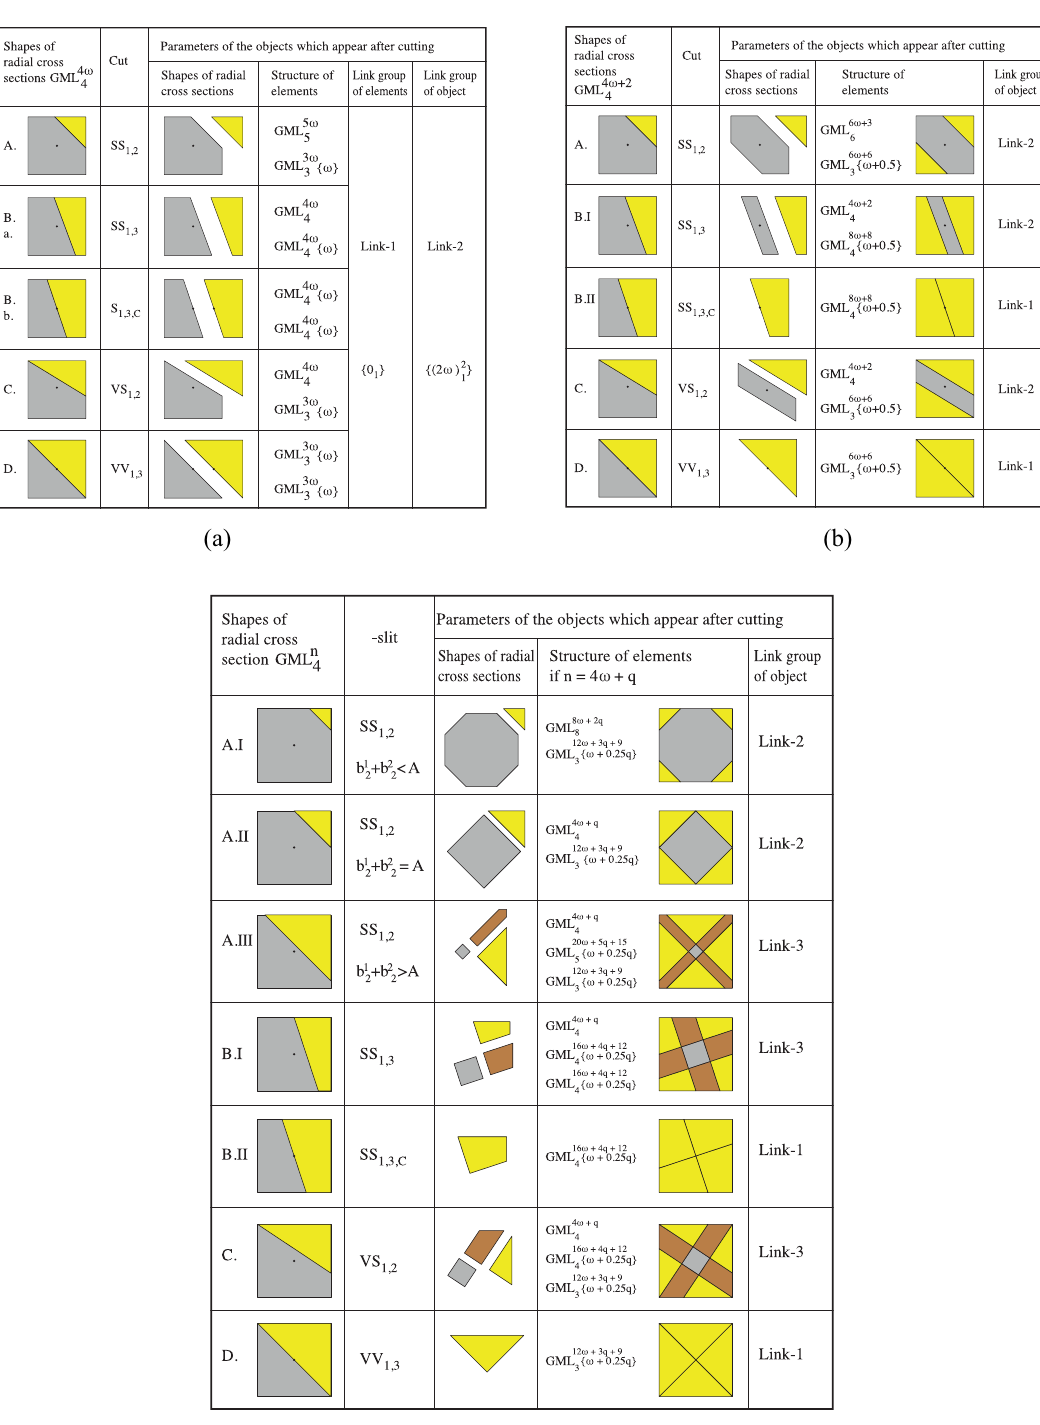
Figure 15. Cutting (a) GML 4 x bodies and their link number [5]. The independent objects and their shapes are given in different